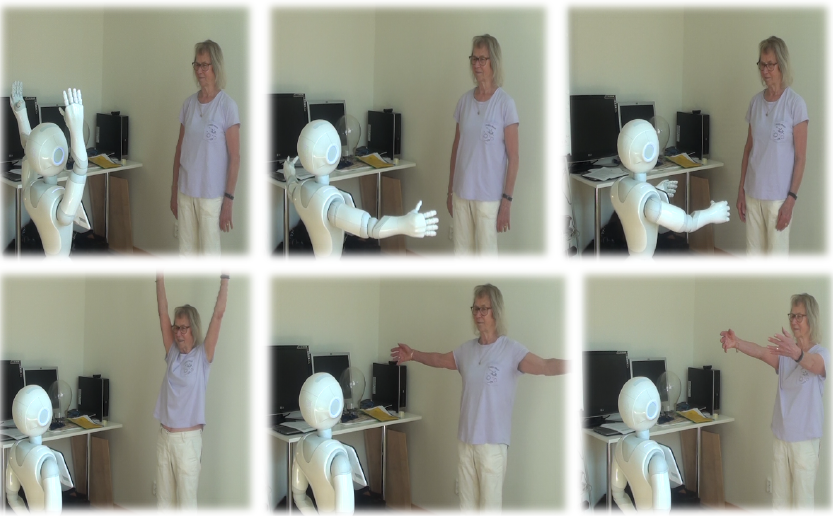
Figure 2. An older participant is interacting with the Pepper robot (the participant has provided consent for using her pictures in this